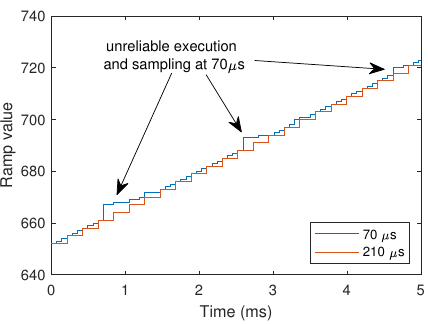
Figure 11. Ramp visualization in the demo model at the controller sampling frequency and under- sampled by a factor of 3 (ARM sampling period of 70 µ s and 210 µ s, respectively).